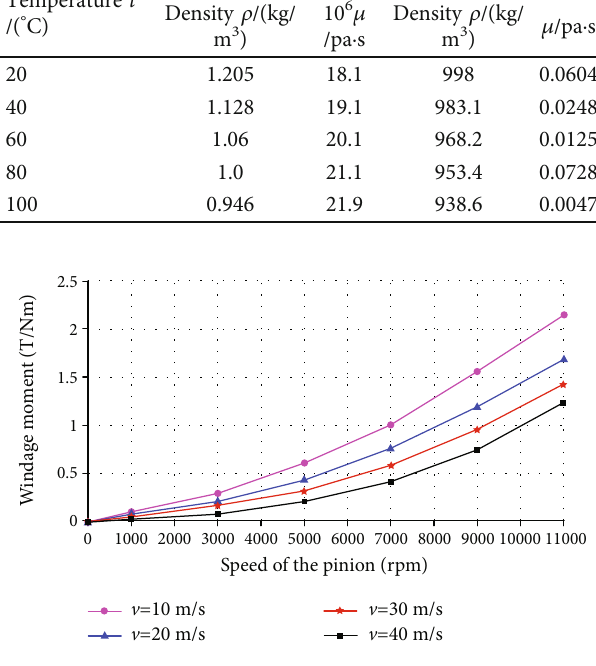
Figure 15: E ff ect of oil-jet temperature on windage moment of gear pair.